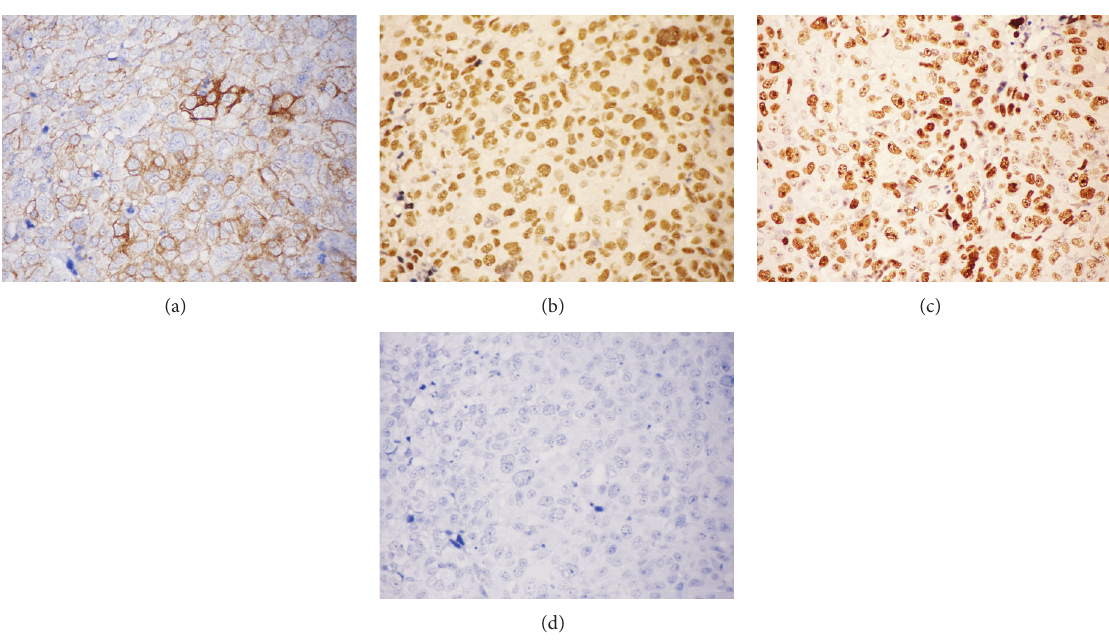
Figure 2: Immunohistochemical staining (IHC) evaluation of the tumor. (a) AE1/AE3: positive and diffuse cytoplasmic immunoexpression (400x); (b) p63: positive and diffuse nuclear immunoexpression (400x); (c) Ki-67: high cell proliferation index (approximately 70%) (400x); (d) thyroglobulin, TTF-1, CEA, and calcitonin: negative immunoexpression